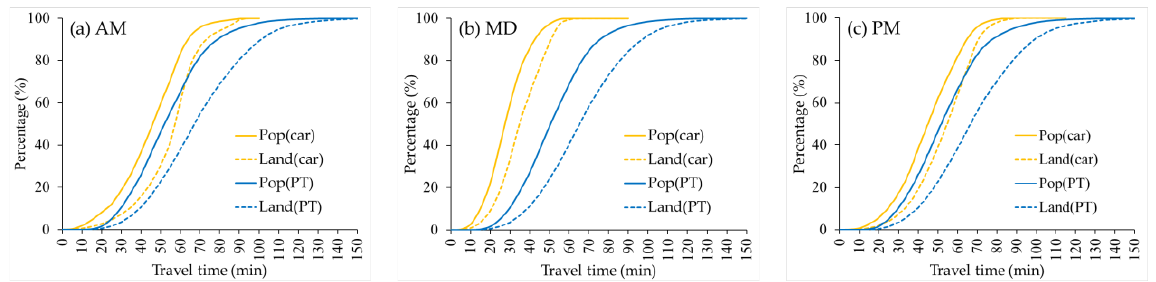
Figure 4. Growth curves of cumulative land and population percentages as travel time increases: ( a ) during AM; ( b ) during MD; ( c ) during